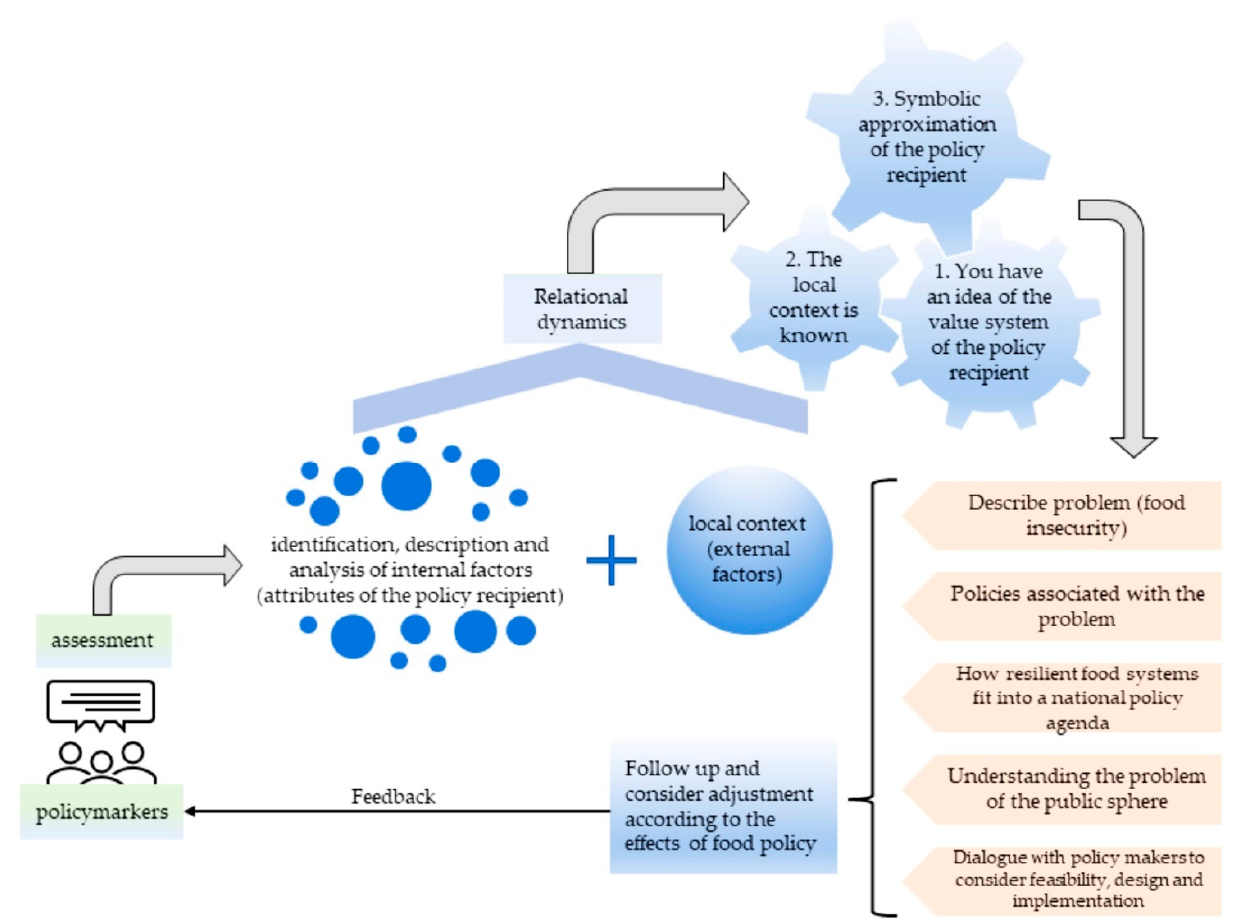
Figure 3. Theoretical model for food policy design.